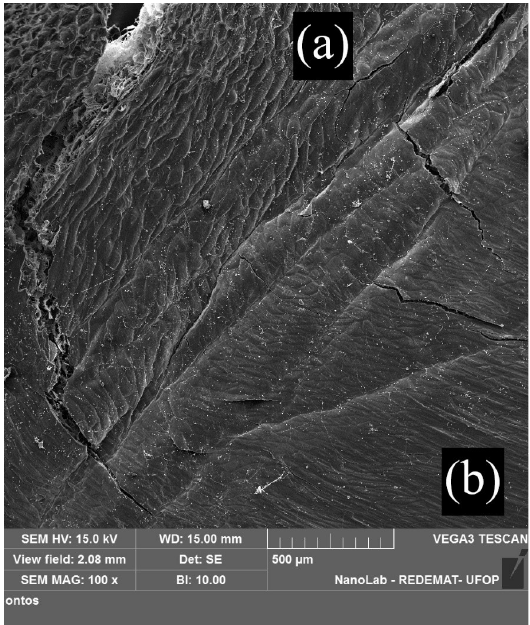
Figure 2. Non-uniform epidermis detail. The cuticle is (a) beehive- shaped and (b) striated.